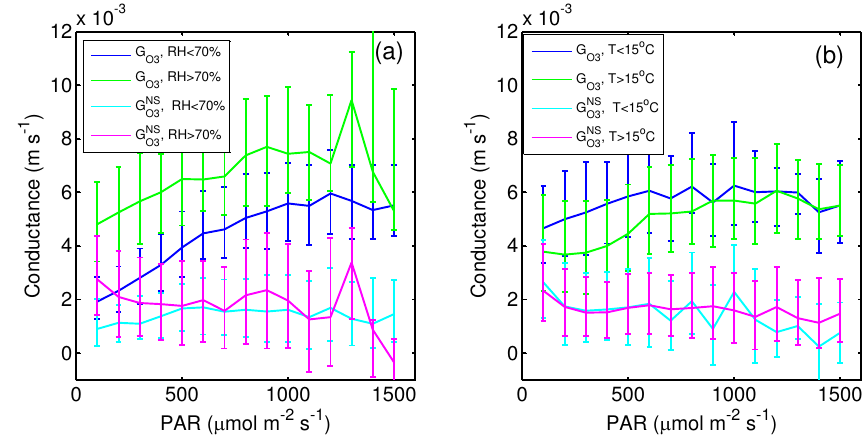
Fig. 6. Day-time (elevation angle of sun >10 ◦ ) ozone conductance as a function of PAR during the peak of the growing season weeks 25–34. 70% and 15 ◦ C were used as the values to separate high and low relative humidity (a) and temperature (b) conditions. Medians of 30min average observations together with quartiles are